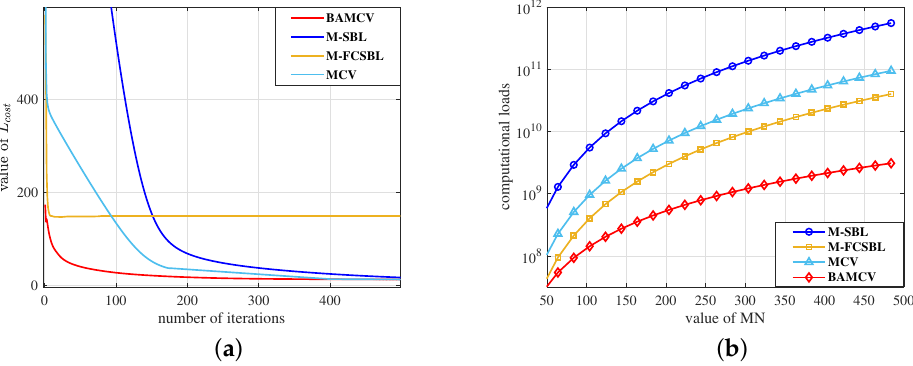
Figure 10. Analysis of convergence and computational loads. ( a ) Convergence curves of different methods using simulated data. ( b ) Comparison of computational